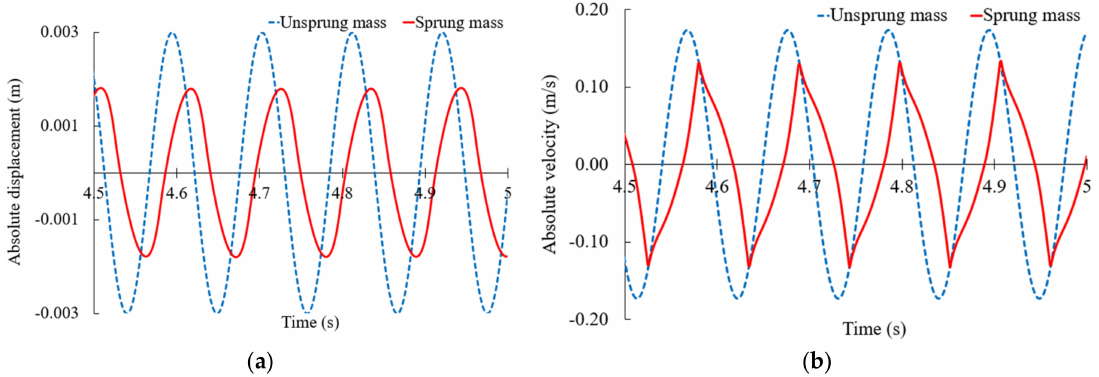
Figure 8. Response of the time domain of ( a ) displacement, ( b ) velocity, and ( c ) acceleration of the sprung and un-sprung mass with the excitation frequency equal to a half of the natural frequency.